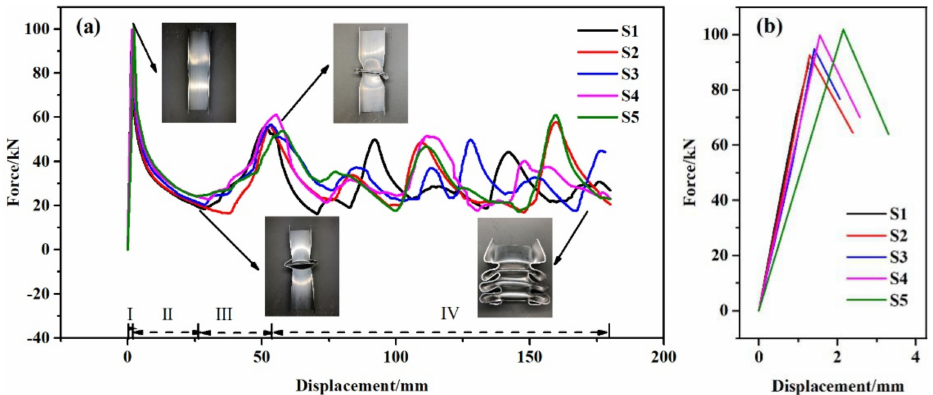
Figure 4. ( a ) Crushing curves of five samples: (I) elastic stage, (II) bending stage, (III) compaction stage, (IV) folding stage, ( b ) peak force of five samples.